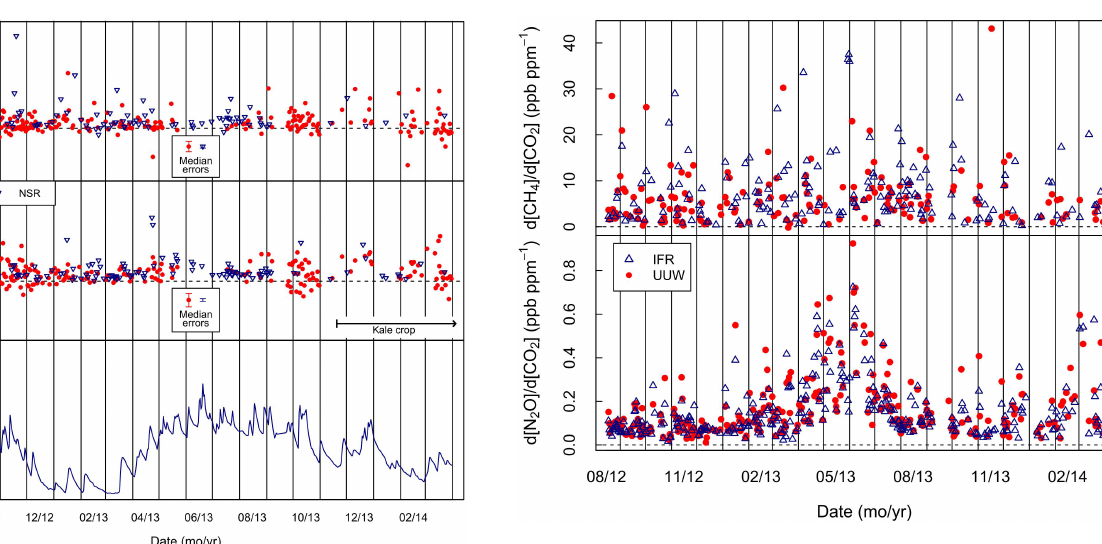
Figure 8. Temporal variation of the slopes of the linear regressions between CH 4 and CO 2 (top panel) and between N 2 O and CO 2 (bot- tom panel), for both